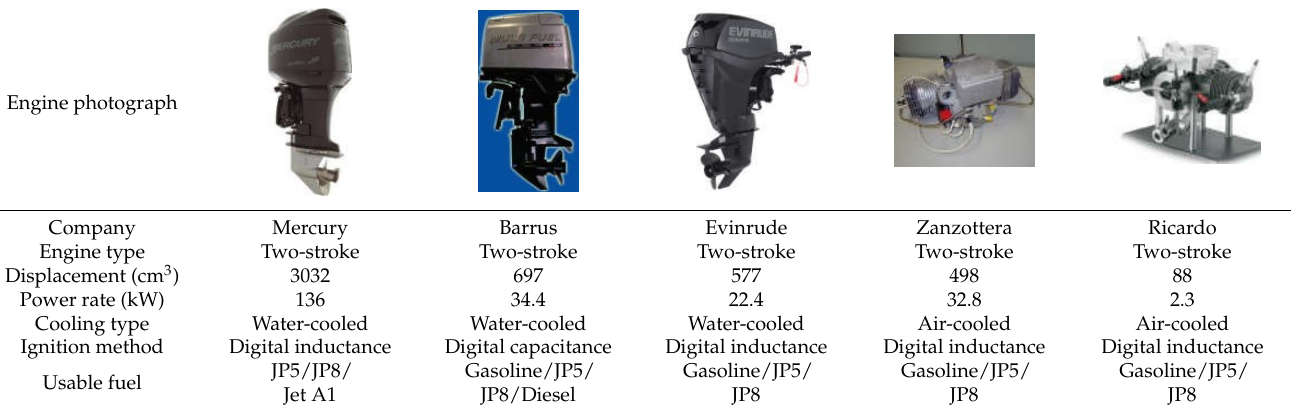
Table 3. Comparison of heavy-oil, two-stroke, direct-injection, ignition engines in multiple applications.